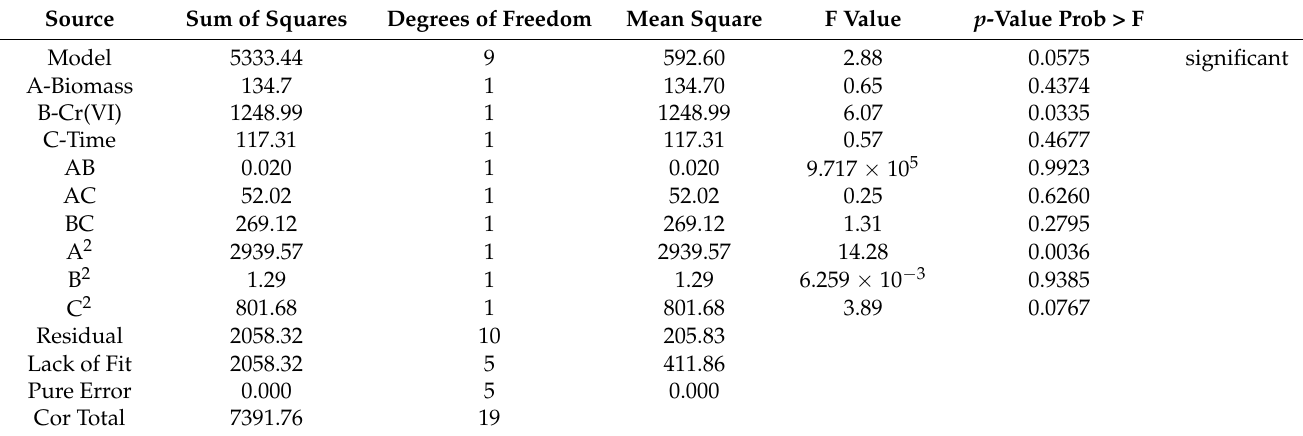
Table 5. ANOVA of percentage of adsorbed Cr in biomass with the quadratic model of Equation (4).